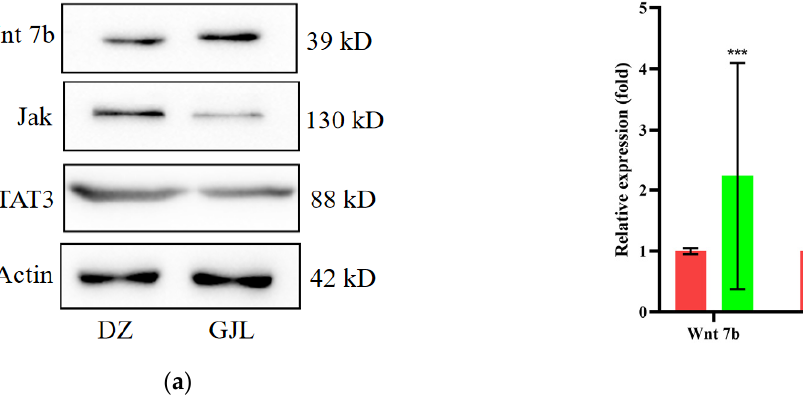
Figure 6. Western blot assay of differential gene expression between DZ and GJZ; ( a ) The image of protein bands in Western blot assay; ( b ) the data were quantitated and graphed. Data represent the means ± SD of three independent experiments, GJL vs. DZ of HacaT cells. * p < 0.05, *** p < 0.01; compared with the DZ groups.